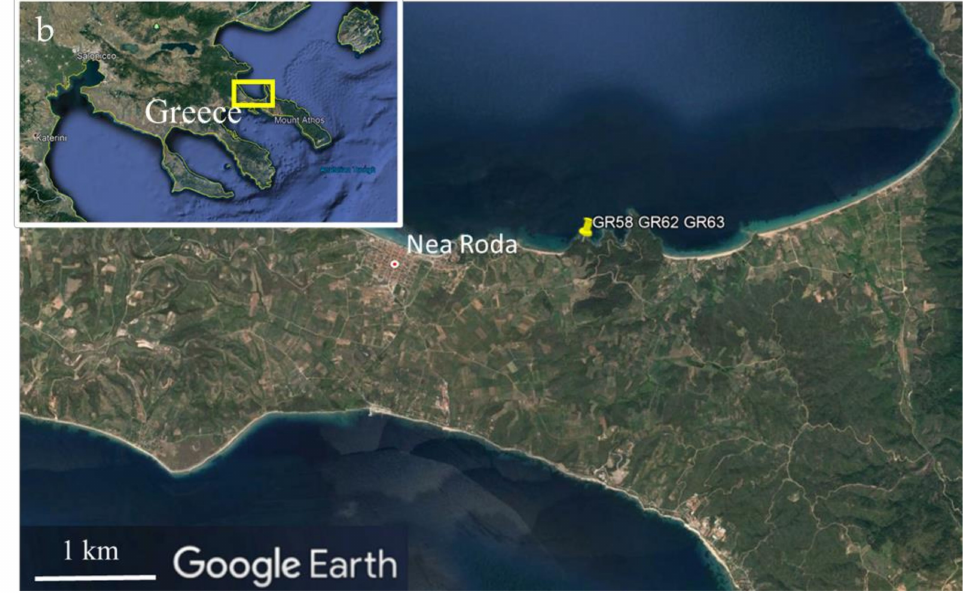
Figure 3. Sampling position (Google Earth) of ( a ) Iballe chromitite (42 ◦ 11 (cid:48) 5.13 (cid:48)(cid:48) N, 19 ◦ 57 (cid:48) 17.03 (cid:48)(cid:48) E) and dunite samples (42 ◦ 11 (cid:48) 29.57 (cid:48)(cid:48) N, 19 ◦ 57 (cid:48) 24.34 (cid:48)(cid:48) E); ( b ) Nea Roda nodular and banded chromitites (40 ◦ 22 (cid:48) 49.56 (cid:48)(cid:48) N, 23 ◦ 57 (cid:48) 8.49 (cid:48)(cid:48) E).